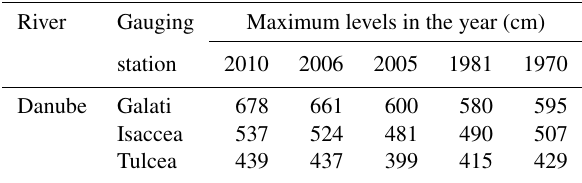
Table 4. Maximum water levels during flooding in the summer of 2010 for the Danube compared to values from other flood years.